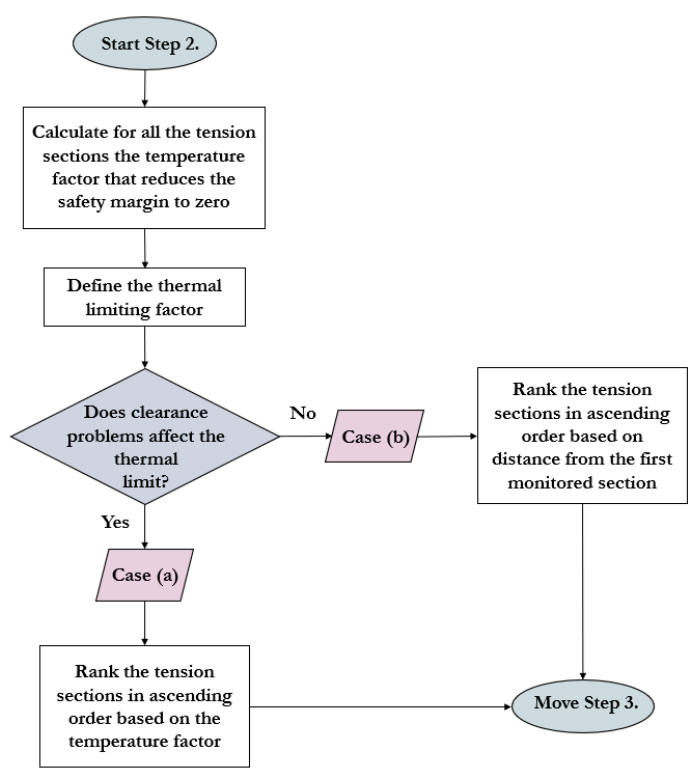
Figure 3. Flowchart of Step 2 in the novel sensor placement protocol based on [16].